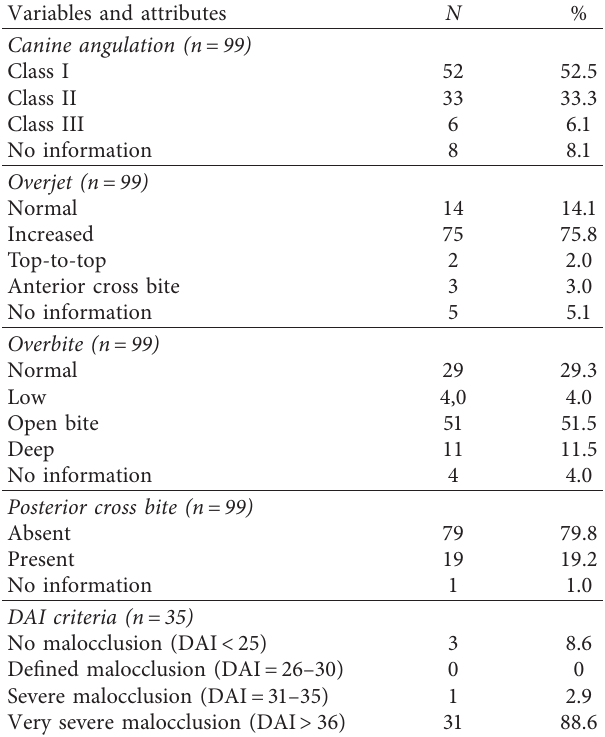
Table 1: Distribution of children and adolescents with CP according to the presence of malocclusion and DAI. Variables and attributes